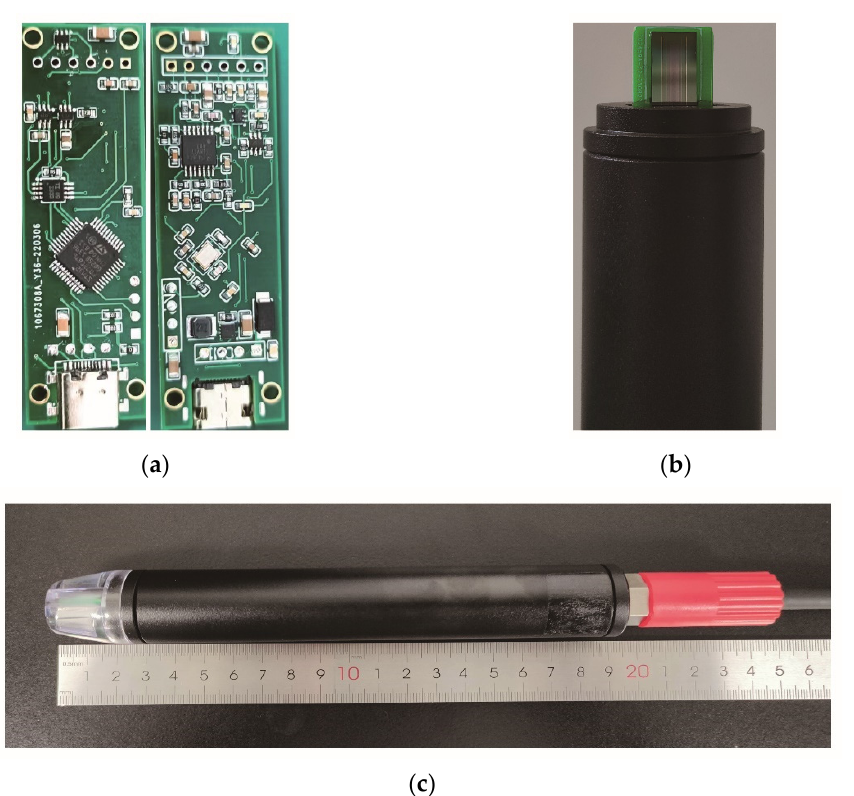
Figure 4. ( a ) The size of circuit board with double-sided patch is 57.5 mm × 18 mm × 1.5 mm; ( b ) a corrosion-resistant epoxy potted probe; ( c ) the assembled conductivity sensor with a length of 20 cm.